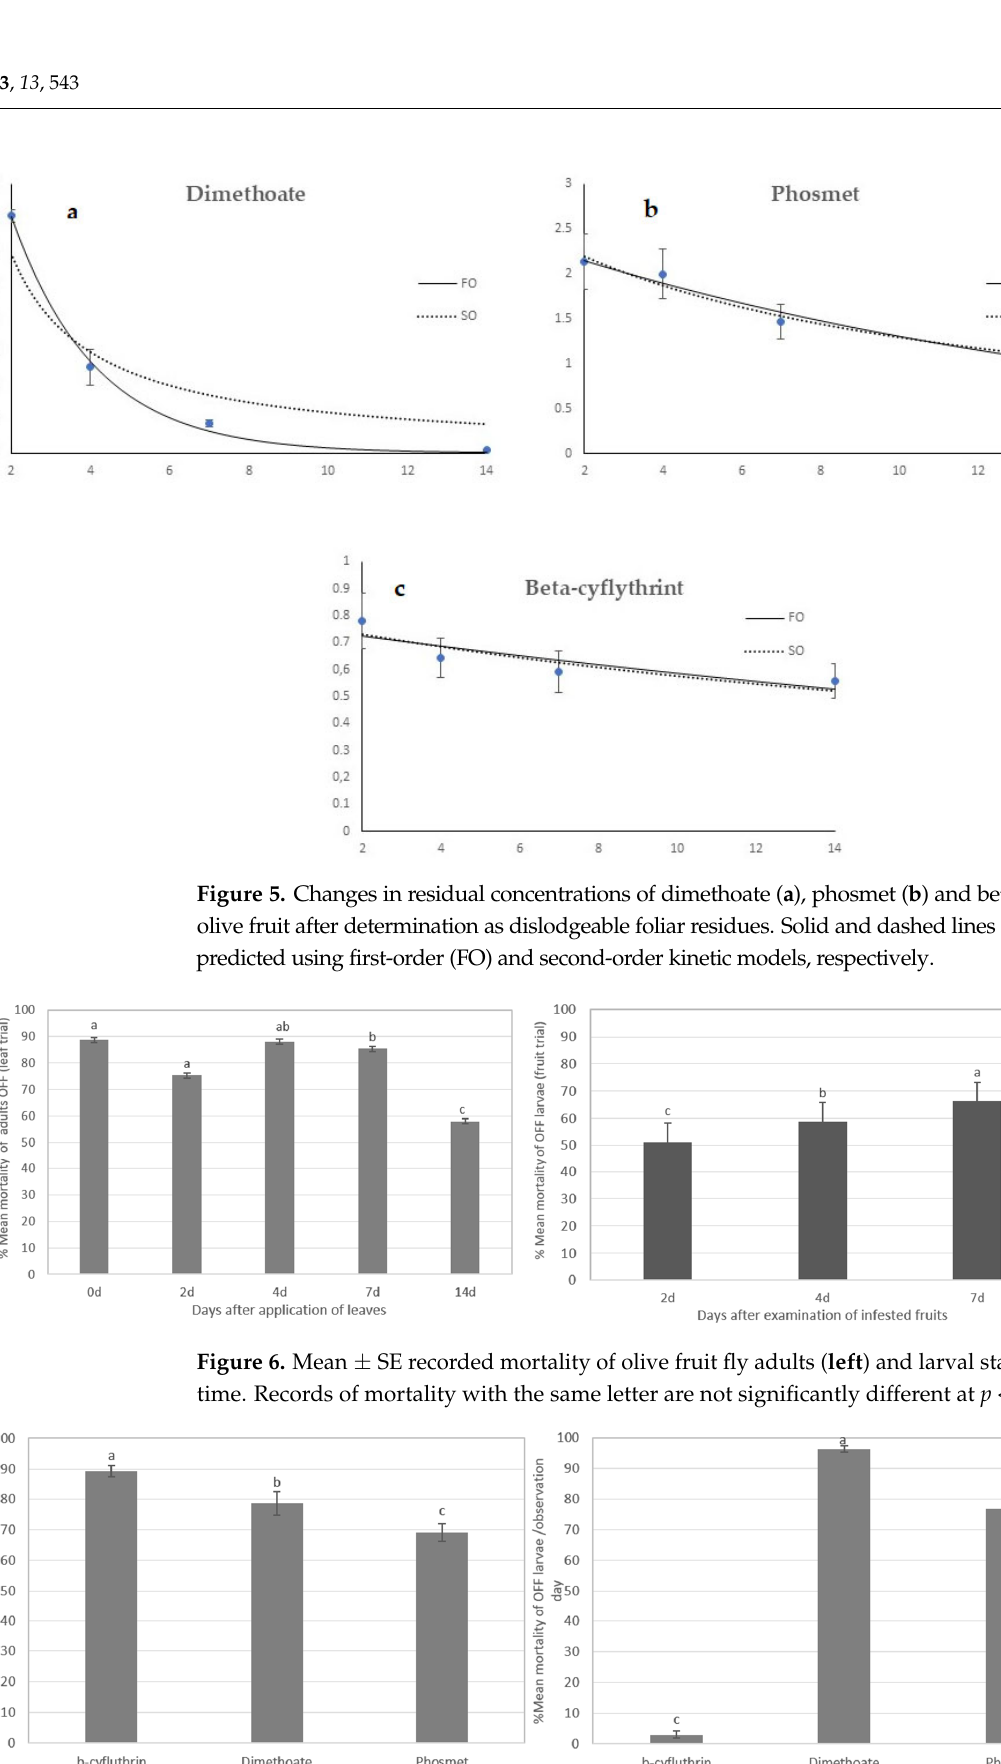
12 of 18 Figure 4. Changes in residual concentrations of dimethoate ( a ), phosmet ( b ) and beta ‐ cyfluthrin ( c ), in olive leaves after determination as dislodgeable foliar residues. Solid and dashed lines indicate the results predicted using first ‐ order (FO) and second ‐ order kinetic models, respectively. Similar reduction levels were also observed in olive fruit (Figure 5). By the last sam ‐ pling of 14 days, only 1.27% of the initially determined concentration was recovered for dimethoate, while the corresponding levels of phosmet and beta ‐ cyfluthrin were 48.86 and 71.31%, respectively. As can be seen, the first ‐ order model seems to achieve better fitting to dimethoate dissipation rates, while for phosmet and beta ‐ cyfluthrin, both models show a similar fit.